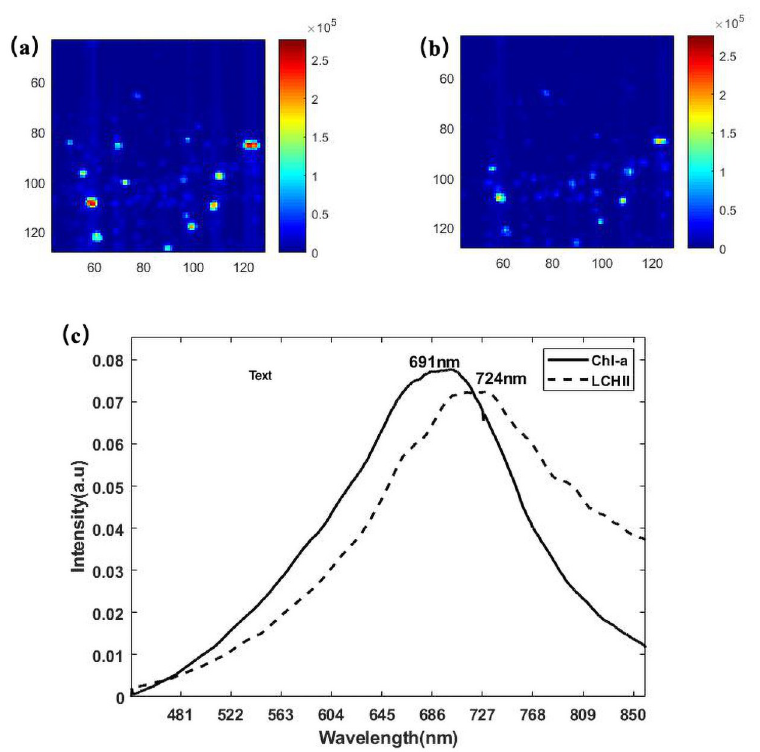
Fig 6. MCR analysis of Chlorella sp. for the entire spectrum. (a) Concentration image of carotenoids resulting from analysis of the entire spectral area using MCR. (b) Concentration image of CHl-a resulting from analysis of the entire spectral area using MCR. (c) MCR pure-component spectrum containing the PBS component (solid line) and chlorophyll-a (dotted line). Color scales are identical for all images to facilitate comparison between images. The x-axis and y-axis of the image represent image size (pixels).